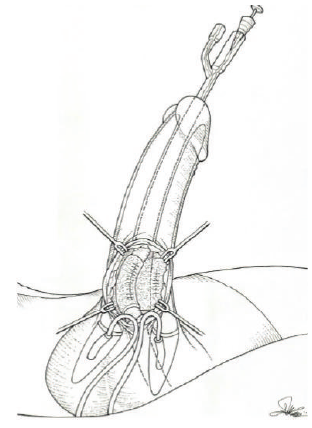
Figure 4: TachoSil patch covering urethral and left corpus caver- nosum